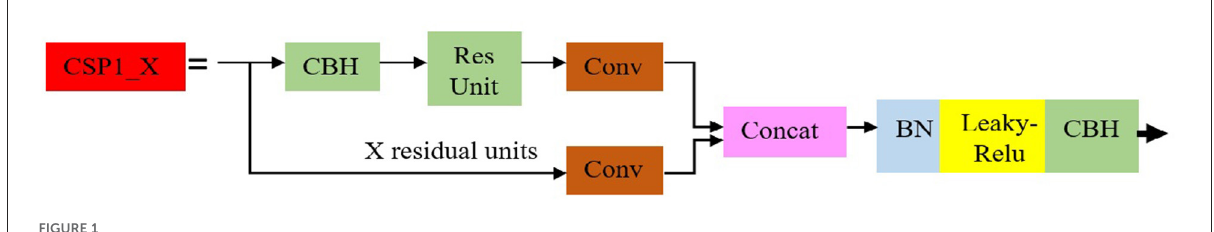
FIGURE1 The fine-tuned module